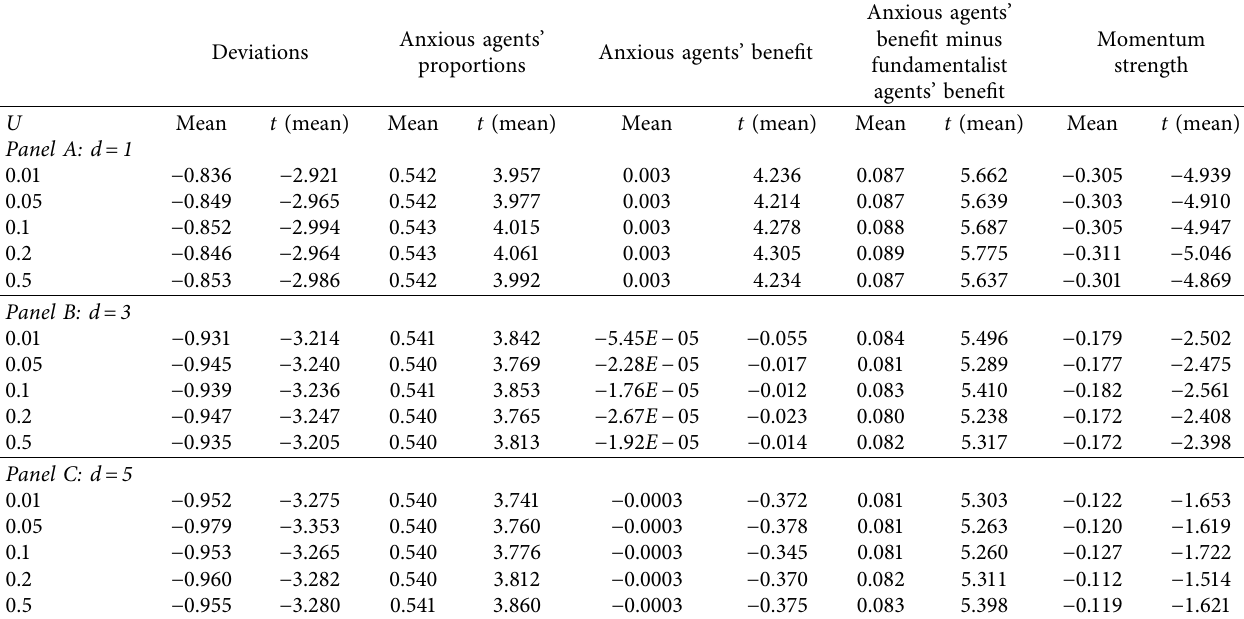
Table 3: Simulations for the upper bound of irrationality. Note: In this table, by focusing on the upper bound of irrationality in agent evolutions, we dissect deviations from the fundamental information, market proportions of anxious agents, the benefit of the anxious agents’ strategy, the difference in the benefit between the anxious and fundamentalist agents, and the momentum strength. The magnitudes of the lack of confidence and behavioral hesitation (denoted by d ) are 1, 3, and 5, respectively. When d equals 1, the expectation for price of the ) � p + λ × F x anxious agent can be written as E x t ( p j,t + j,t j,t − 1 . Hence, the anxious agent does not embody hesitation since the agent only 1 relies on the single-period forecast error in such a case. However, hesitation begins to emerge if d is 2 or over 2 since the agent refers to multiperiod forecast errors. The upper bounds are 0.01, 0.05, 0.1, 0.2, and 0.5, respectively. In order to ensure the accuracy of statistical inference, we thus follow Gatti and Grazzini [88] and Garc´ıa-Magariño et al. [1, 8]] to perform a one-sample t -test for each simulation window. Equipped with such endeavors, we proceed to calculate the averages of the t -statistics across windows.